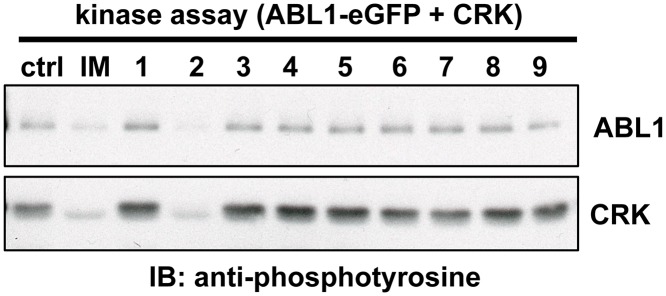
Theaflavin-3,3’-digallate is a direct ABL kinase inhibitor.0.5 nM purified ABL-eGFP was mixed with 2 μM CRK and 10 μM test compound and incubated in kinase buffer for 30 minutes at 30°C. Samples were analyzed by immunoblot using anti-phosphotyrosine. All the hits were screened, and a representative immunoblot is shown here. Test compounds were as follows: DMSO (ctrl), imatinib (IM), CID 16312764 (1), CID 467320 (2), CID 7457610 (3), CID 6084 (4), CID 4844281 (5), IUPAC 1-(4-phenylphenyl)-2-[4-(pyrimidin-2-yl)piperazin-1-yl]ethan-1-ol (6), CID 9291491 (7), CID 3991439 (8) and CID 16350799 (9).